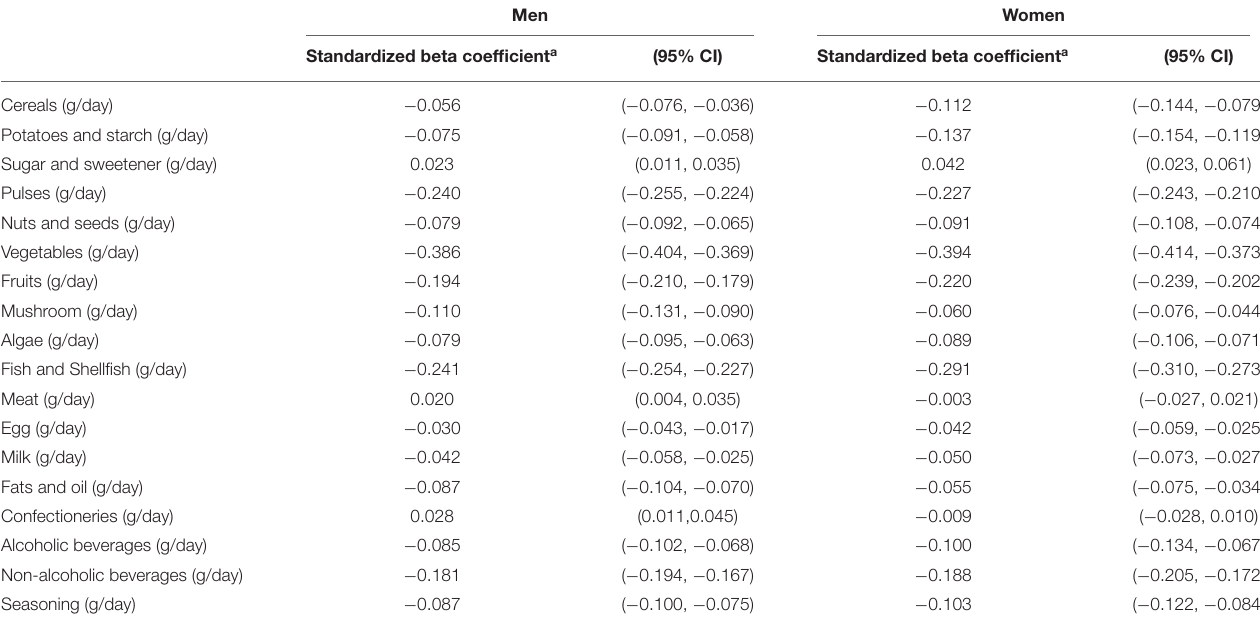
TABLE 2 | Standardized beta coefficient with 95% confidence interval between E-DII score and food groups’ intake by multiple regression analyses in Japanese men and women aged 40–69 years.